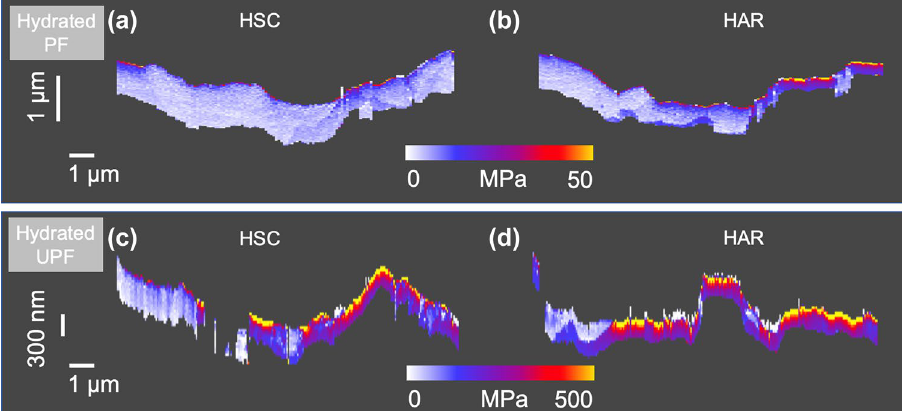
Fig. 9 Cross section of Elok(z) in the xz-direction of a hydrated PF mapped with a an HSC cantilever and b an HAR cantilever. Cross section of Elok(z) in the xz-direction of a hydrated UPF mapped with c an HSC cantilever and d an HAR